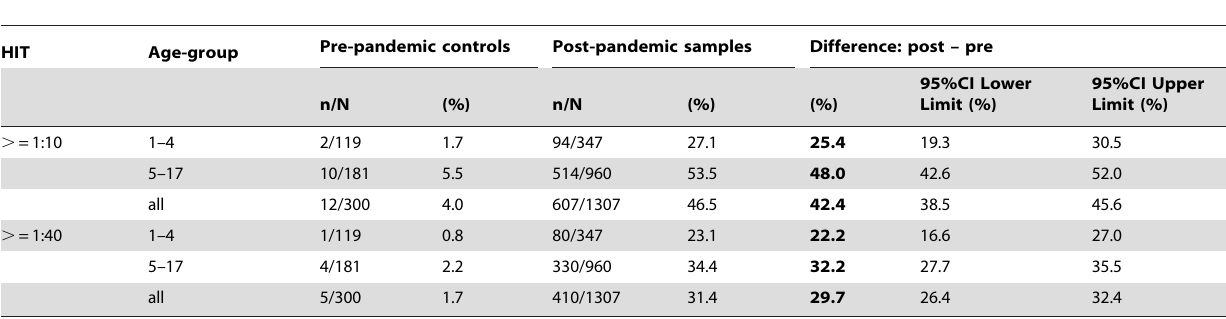
Table 2. Pre-and post-pandemic hemagglutination inhibition titers (HIT) $ 1:10 and $ 1:40 for non-vaccinated children aged 1 to 17 years.